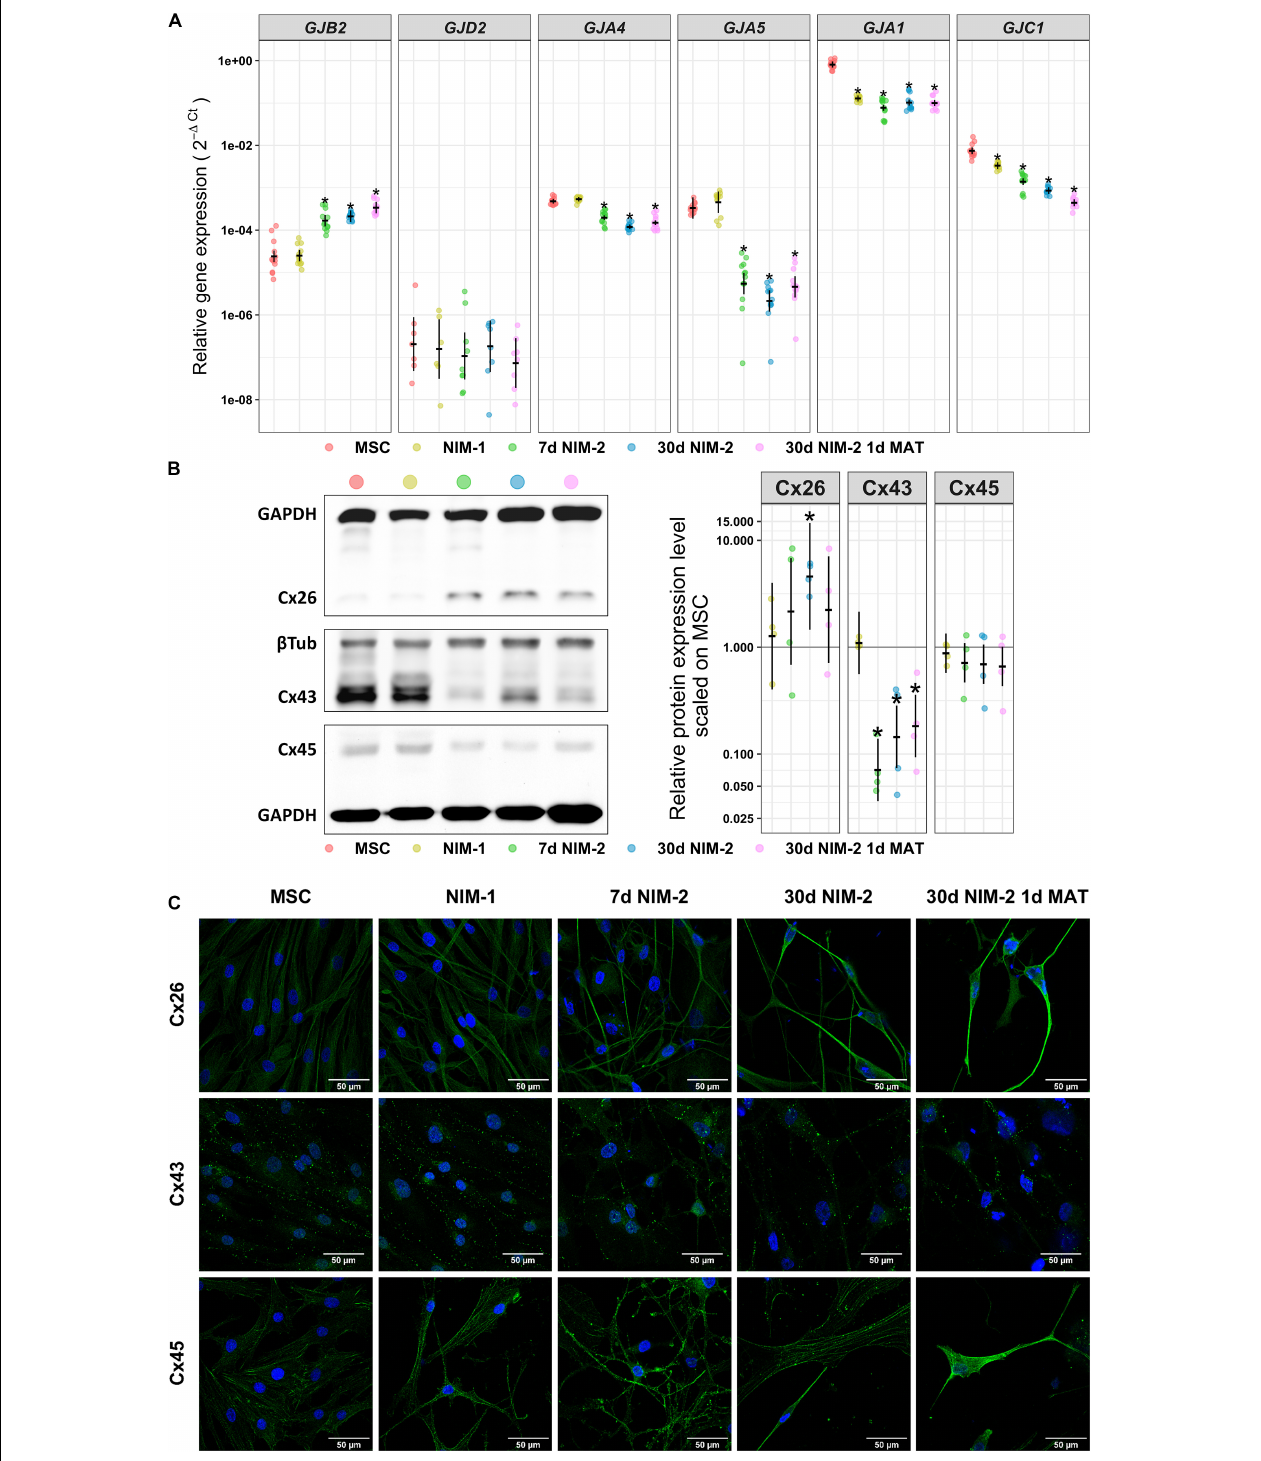
FIGURE 3 | Connexin expression in MSCs and NIM-1- and NIM-2-differentiated cells. (A) qRT-PCR analysis of GJB2, GJA4 , GJA5 , GJA1 , and GJC1 as well as neuronal GJD2 . (B) Western blot analysis of the connexin expression in MSCs and differentiated cells. Exemplary blots are shown on the left and its quantification on the right. (C) Immunocytochemistry staining of Cx26, Cx43 and Cx45 (green) and the nuclei (DAPI, blue). The scale bars represent 50 µ m. In panels (A,B) (right panel) the original data points are plotted in colorful dots. The horizontal lines indicate model-based least-square means together with their 95%-confidence intervals (vertical lines). The * marks significant mean differences ( α = 0.05) between MSCs and the differentiated cells.